Question: Express in one sentence what the figure is showing.
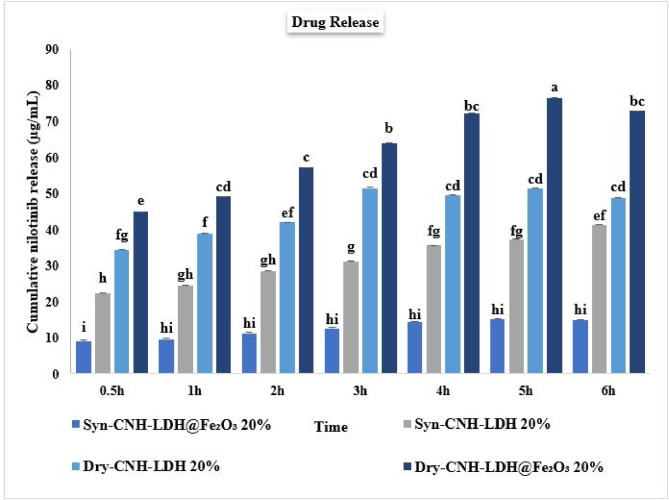
Answer: In vitro release profile of nilotinib from different hydrogel bead formulations: Dry-CNH-LDH (20%), Dry-CNH-LDH@Fe 2 O 3 (20%), Syn-CNH-LDH (20%), and Syn-CNH-LDH@Fe 2 O 3 (20%).